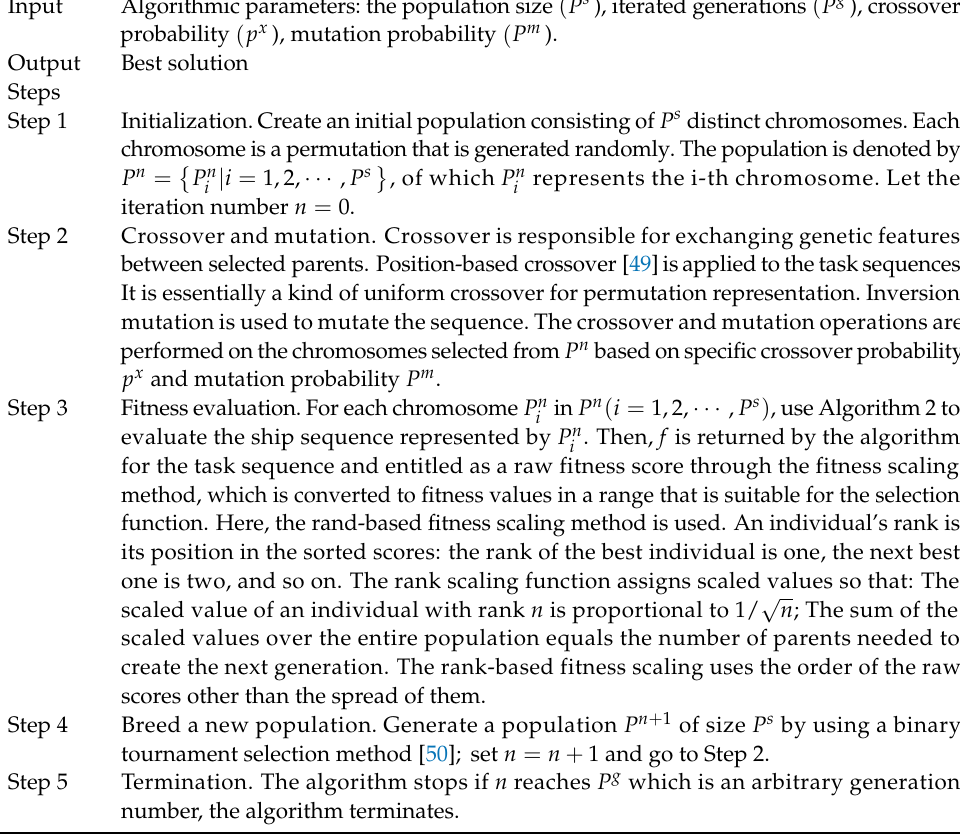
Algorithm 3 The genetic